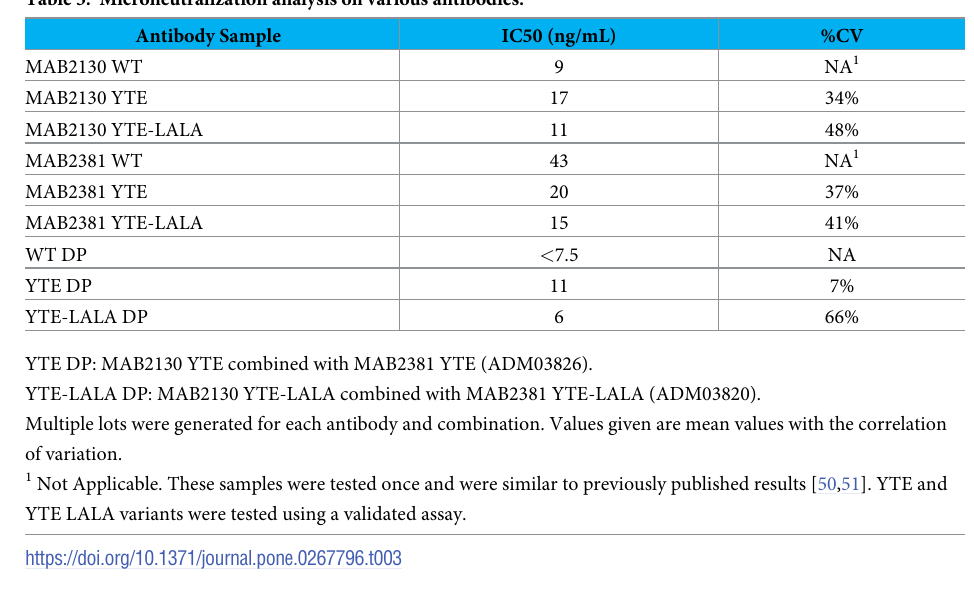
Table 3. Microneutralization analysis on various antibodies. Antibody Sample IC50 (ng/mL)